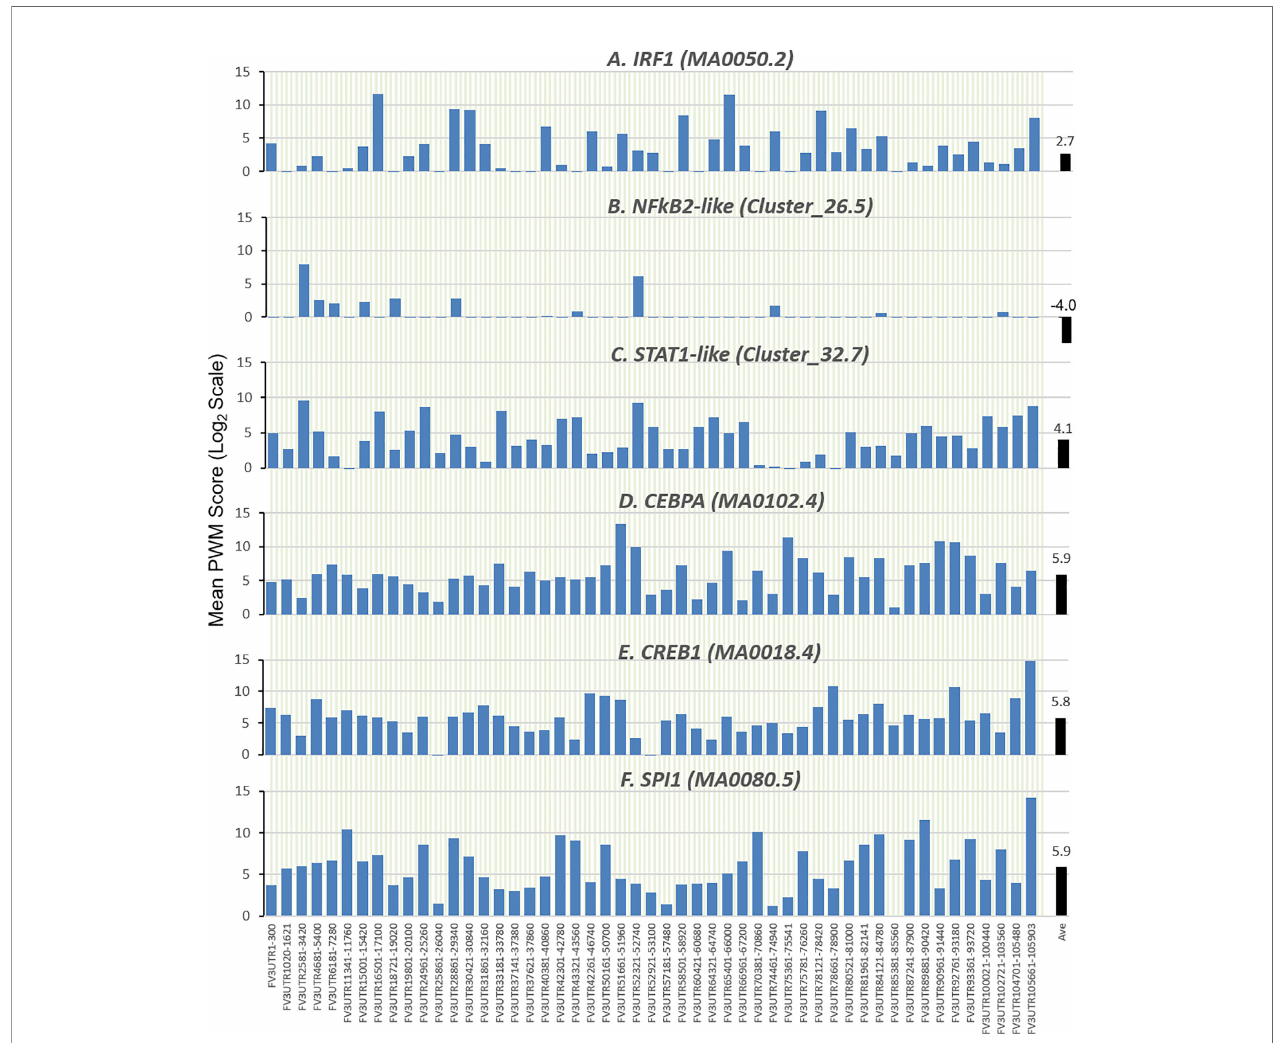
FIGURE 3 | Comparison of position weight matrix (PWM) scores of key cis -regulatory elements (CREs) detected in FV3-genome intergenic regions, and that interact with vertebrate transcription factors potently in immune regulation. Shown are mean PWM scores of CREs in FV3 intergenic regions that were signi fi cantly detected to bind (A) IRF-like, (B) NF- k B2-like, (C) STAT1-like, (D) CEBP-like, (E) CREB-like, and (F) PU.1 (a.k.a. SPI1) transcription factors. Mean PWM scores were calculated using tools at https://ccg.ep fl .ch/pwmtools/pwmscore.php with CRE Matrices (indicated by Matrix or Cluster numbers, and schematics in Figure 4 ) are from MEME-derived JASPAR CORE 2020 vertebrates or JASPAR CORE 2018 vertebrates clustering af fi liated with the PWM tools. The genome-wide mPWM scores across all intergenic regions for each CRE are averagely shown (Ave) as data-labeled black bars at the right for overall comparison. CEBP, CCAAT enhancer binding protein beta; CREB, cAMP-response element binding protein; IRF, interferon regulatory factor; NF- k B, Nuclear factor- k B; SPI1 or PU.1, a TF binding PU-box, a purine-rich DNA sequence; and STAT, signal transducer and activator of